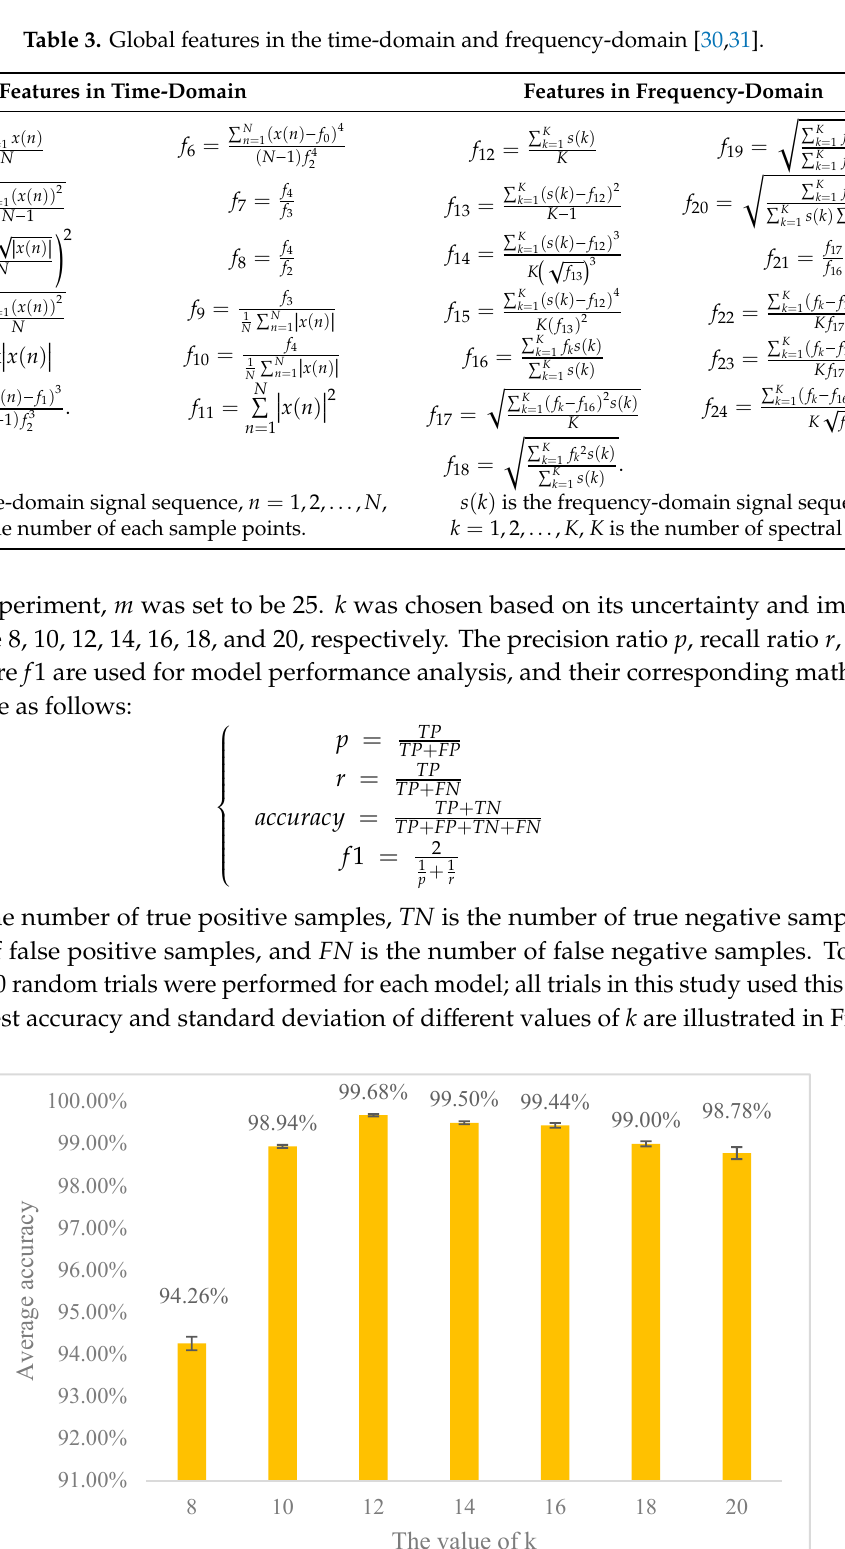
Table 3. Global features in the time-domain and frequency-domain [30,31].